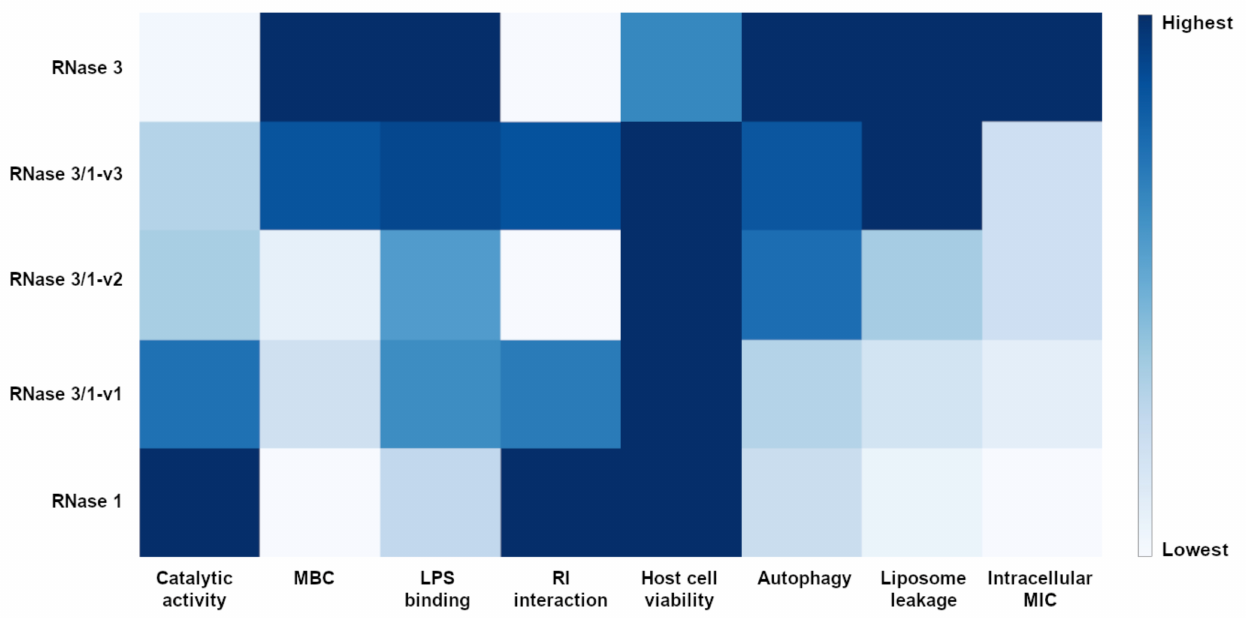
Figure 9. Heatmap depiction for activity comparison of RNase 1, 3 and the three versions of RNase 3/1. All the results were normalized as relative to the highest detected activity and the heatmap was depicted by Plotly and